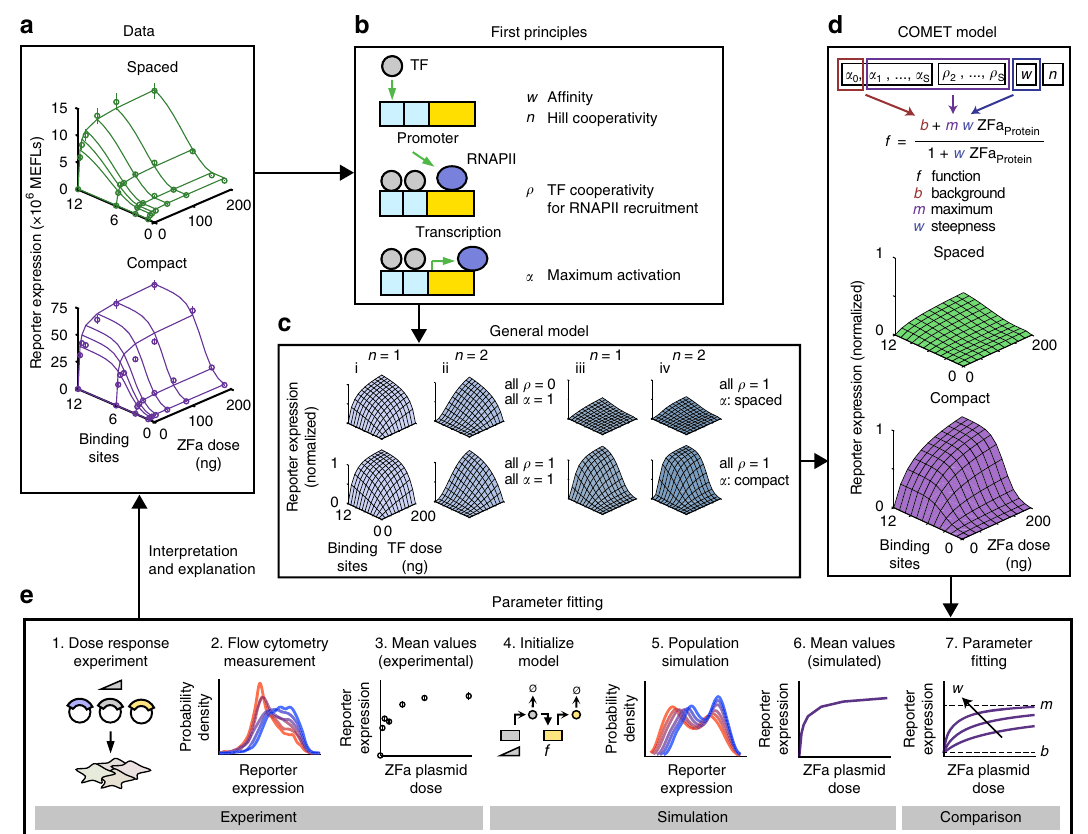
Fig. 2 A model for COMET-mediated gene regulation. This fi gure summarizes the process of model development, re fi nement, and fi tting. a The COMET model (model outputs are represented by the lines on each plot) explains experimentally observed trends (circles) for reporter expression as a function of ZFa dose and promoter features. This model uses a fi tted response function for ZFa-induced gene expression (discussed in b – e ) and simulates a cell population to account for variation in gene expression (Supplementary Fig. 3); lines depict the average outcome for the population. The experiment was conducted in biologic triplicate, and data were analyzed as described in Methods. Error bars represent the S.E.M. b We started with a detailed model of transcriptional activation in which reporter expression depends on TF concentration, a metric related to TF-DNA-binding af fi nity ( w ), TF-DNA-binding cooperativity ( n = 1 for non-cooperative, n >1 for cooperative), RNAPII recruitment cooperativity by each multiple-TF con fi guration at a promoter ( ρ = 0 for non-cooperative, ρ >0 for cooperative), and maximum promoter activation by each con fi guration (0 ≤ α ≤ 1). c This model yielded four types of landscapes (i – iv) under different assumptions, and two representative examples of each type are shown. COMET most closely resembles (iii). d , e A model that represents ZFa-induced reporter expression by a response function was used to fi t the data in ( a ) (the work fl ow for parameter estimation is depicted in e ). The terms in this concise model can be related to terms in the mechanistic model. Landscapes in ( c , d ) are simulations of a single cell (homogenous model), and those in ( a ) are simulated mean values for a heterogeneous population. The outputs of this fi nal fi tted model are represented alongside experimental data in ( a ). Source data are provided in the Source Data fi